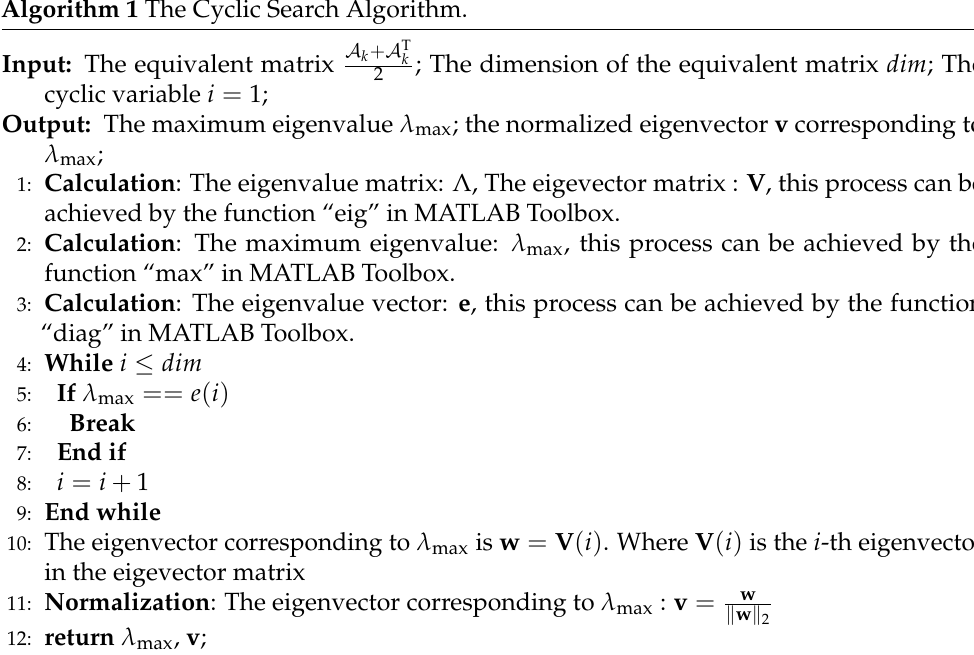
Algorithm 1 The Cyclic Search Algorithm.